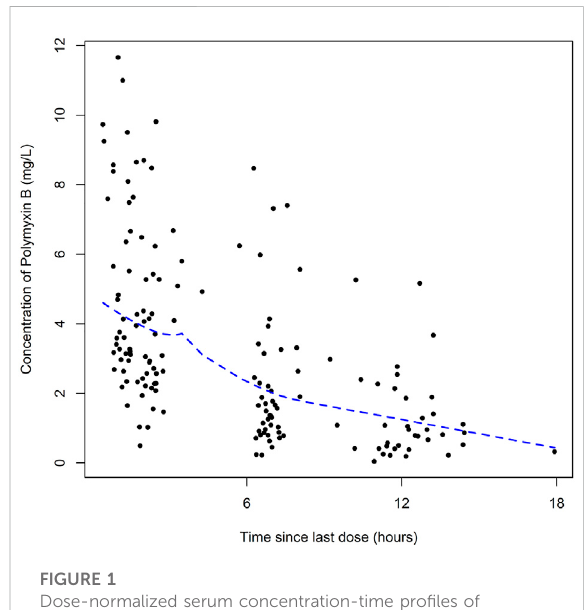
FIGURE 1 Dose-normalized serum concentration-time pro fi les of polymyxin